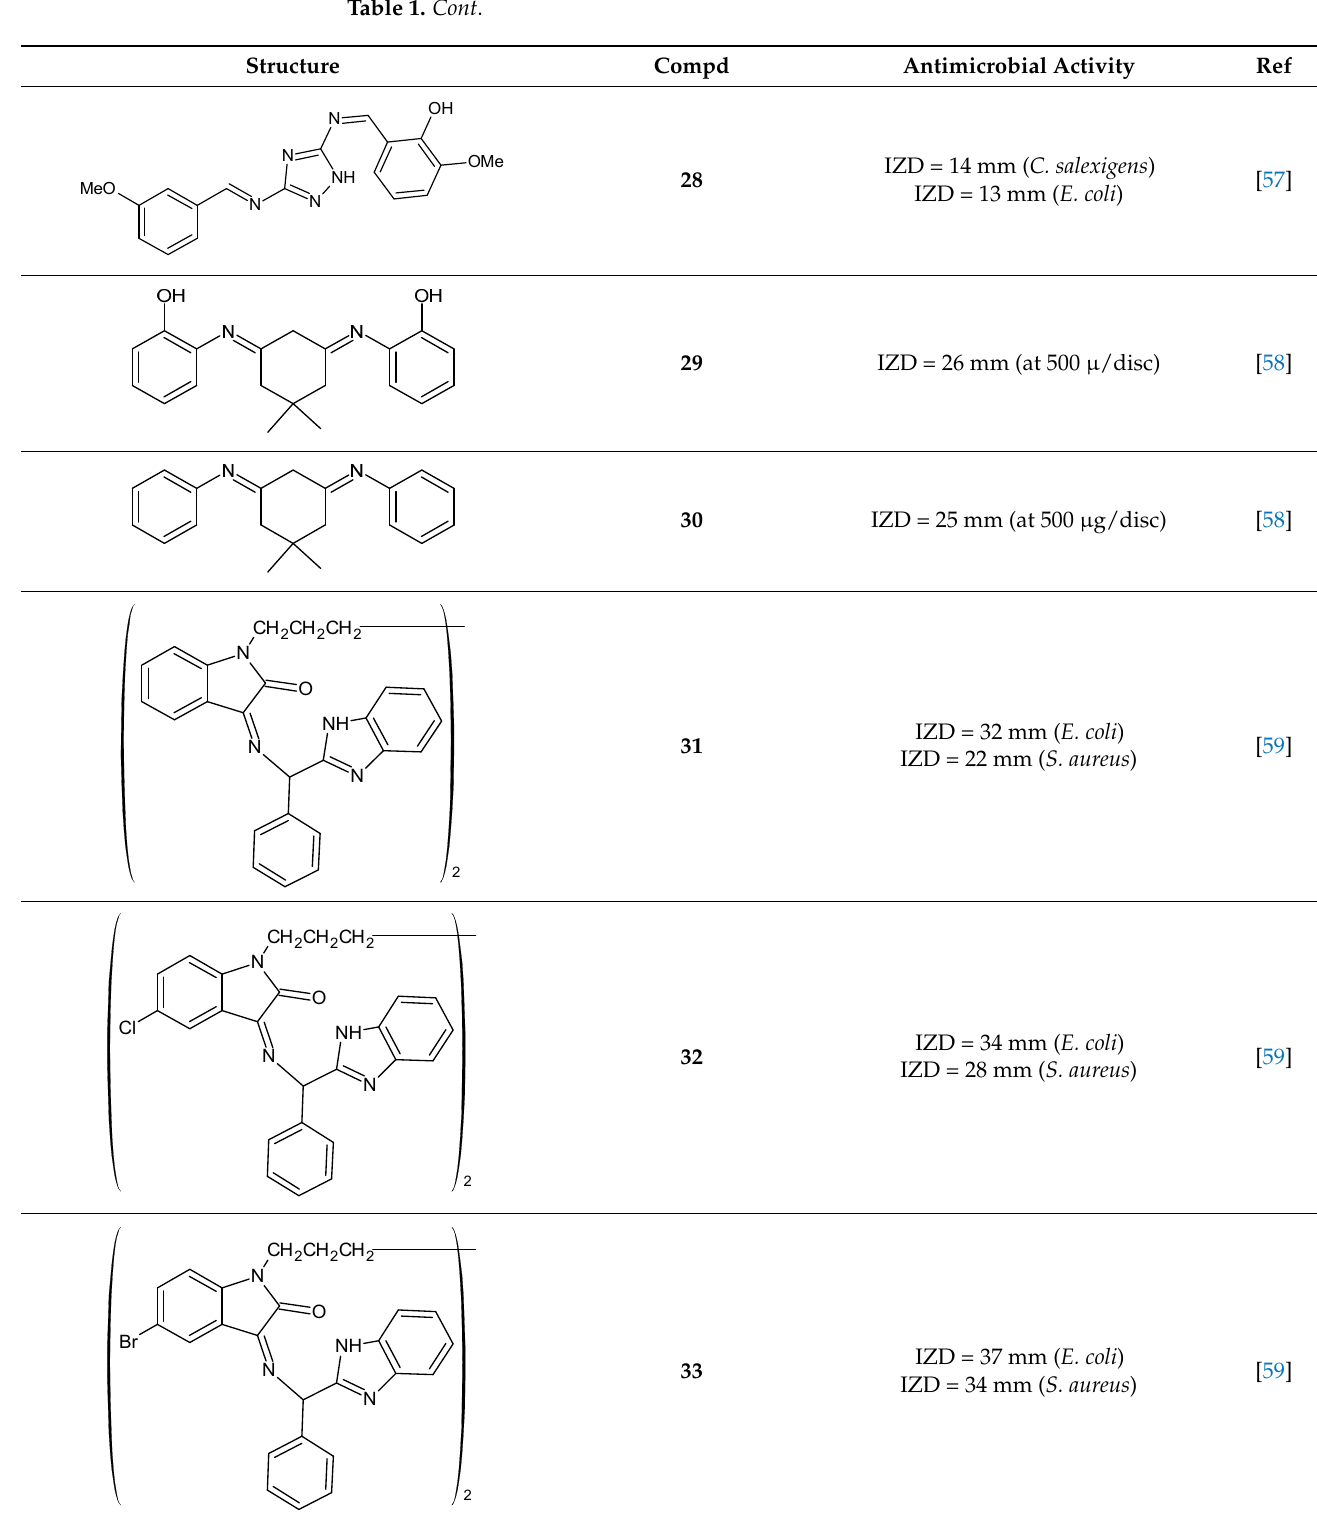
(MIC = 250 ng/mL against S. aureus versus 0.5 ng/mL of ciprofloxacin). Despite the